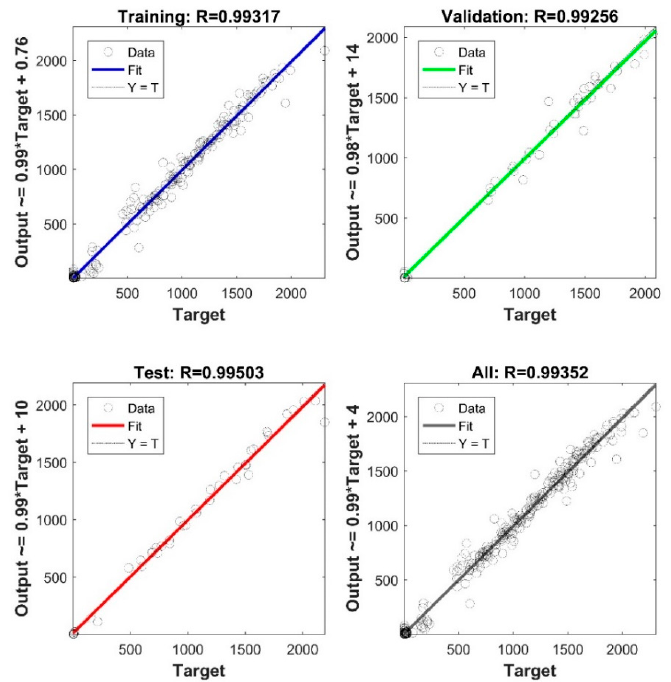
Figure 10. The performance of the developed 5-9-1 neural network to approximate the storage modulus of the 3D prints.